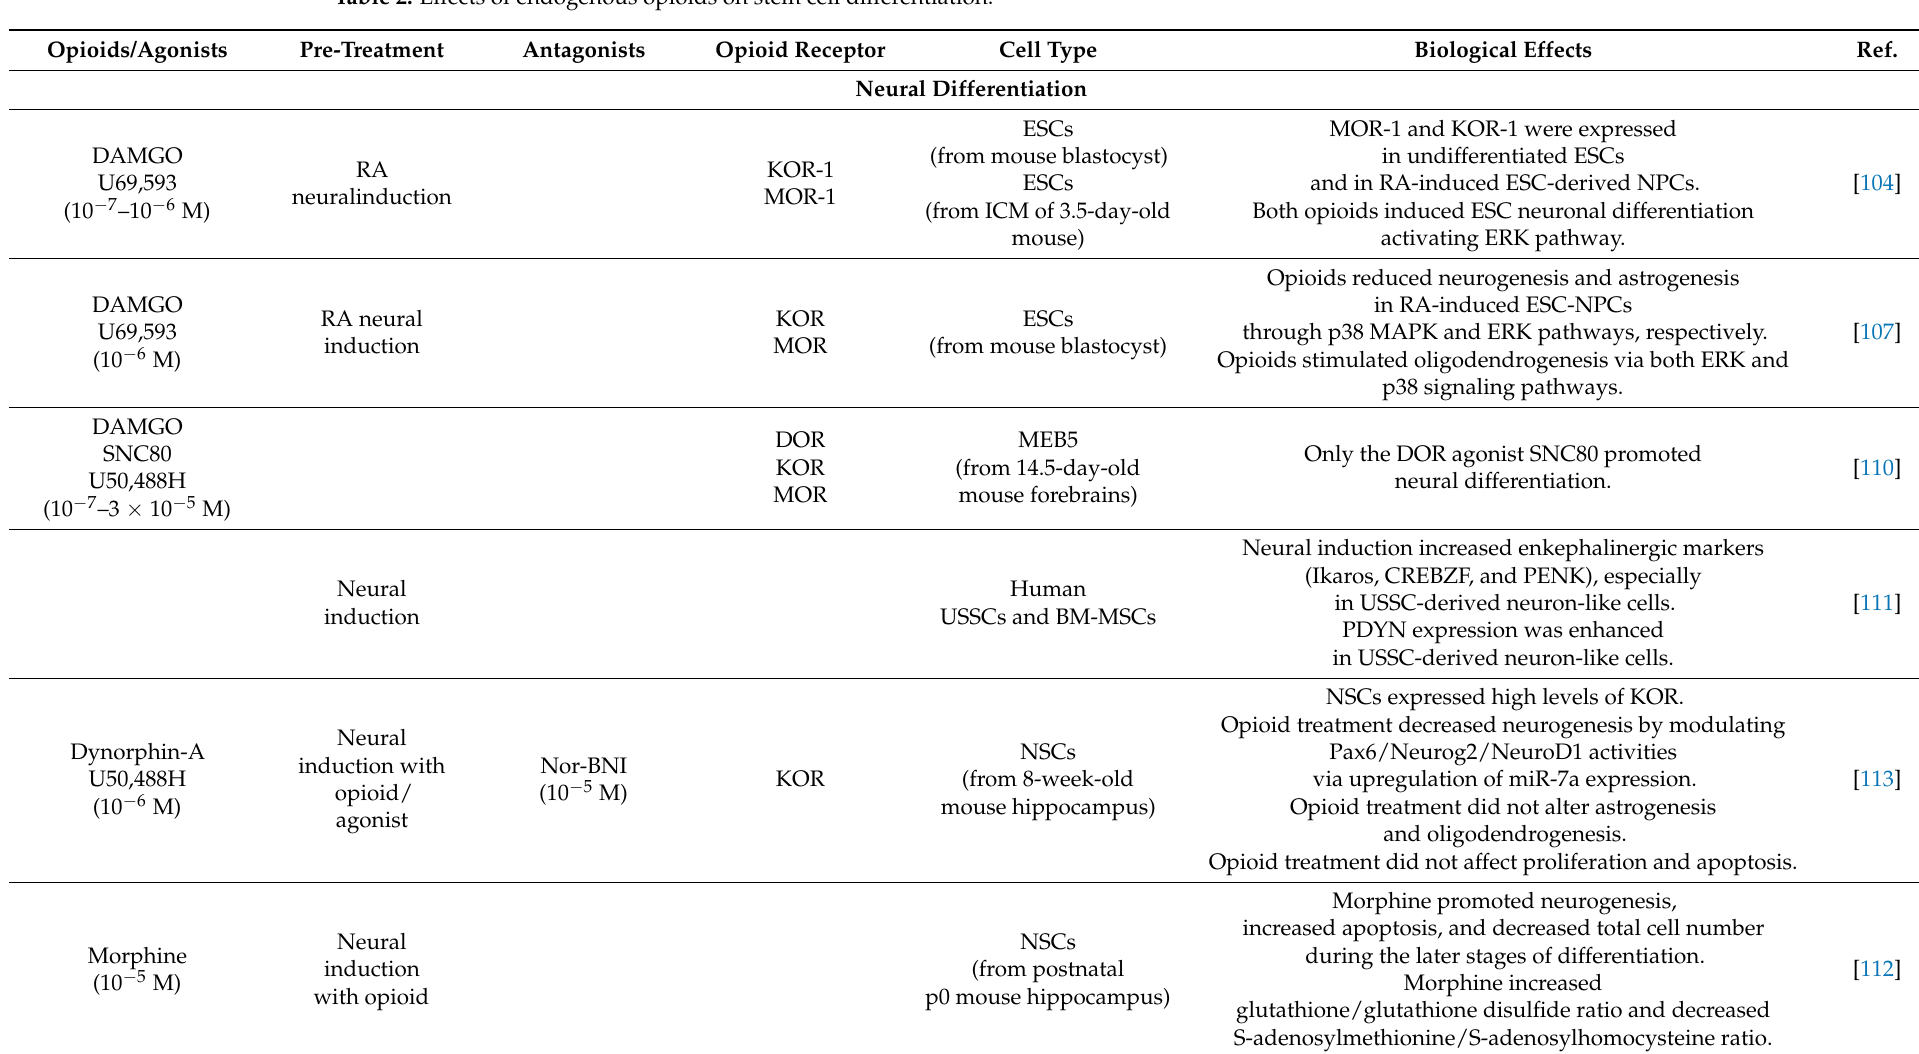
Table 2. Effects of endogenous opioids on stem cell